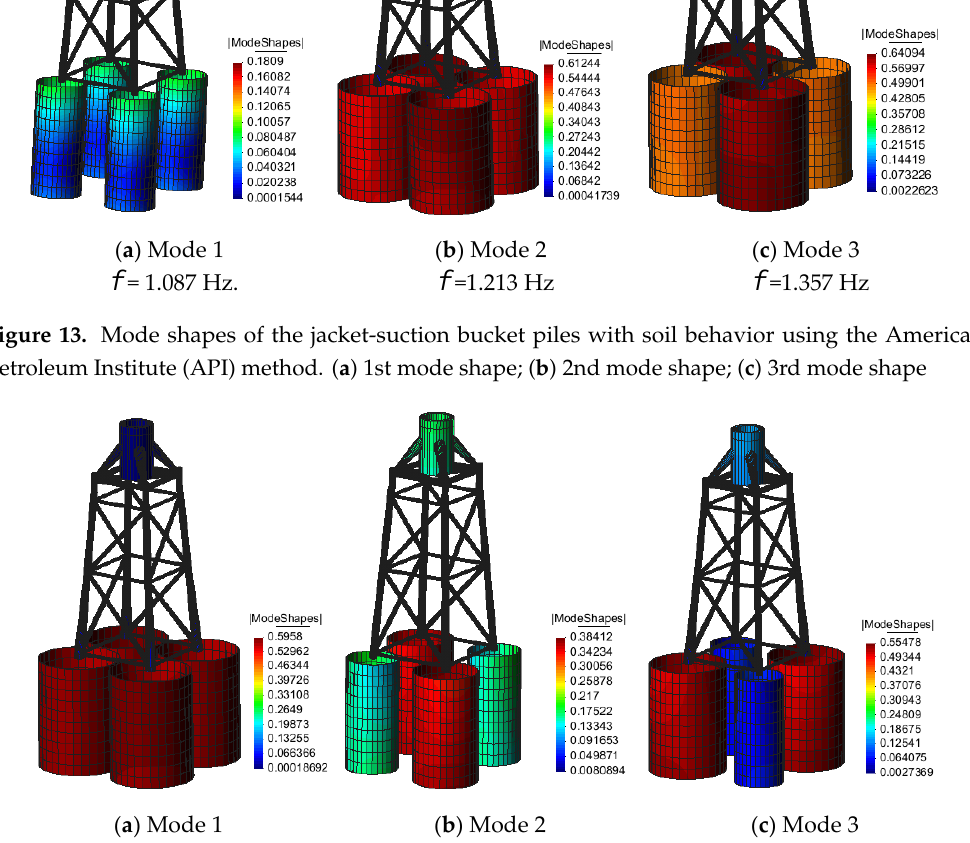
Figure 13. Mode shapes of the jacket-suction bucket piles with soil behavior using the American Petroleum Institute (API) method. ( a ) 1 st mode shape; ( b ) 2 nd mode shape; ( c ) 3 rd mode shape